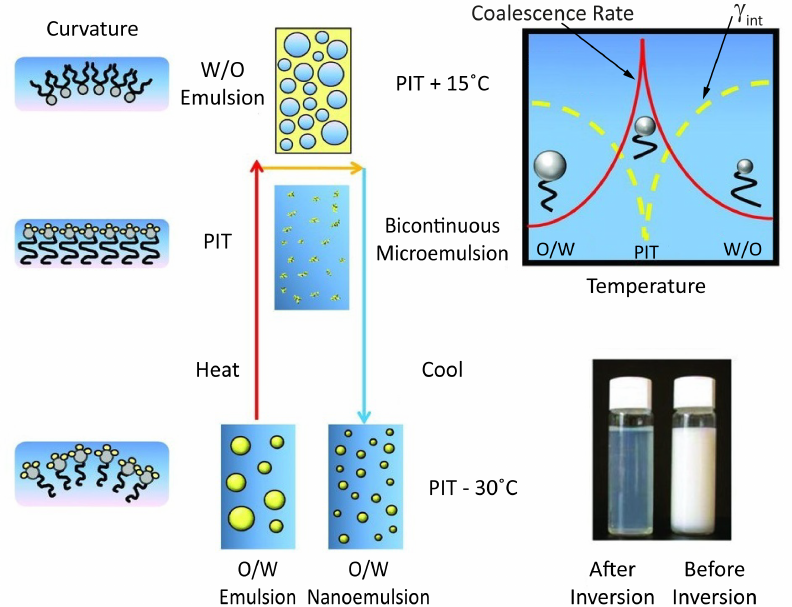
Figure 29. Diagram describing the formation of nanoemulsions using the phase inversion temperature (PIT) method. Figure reproduced from Ref. [115]. W/O: